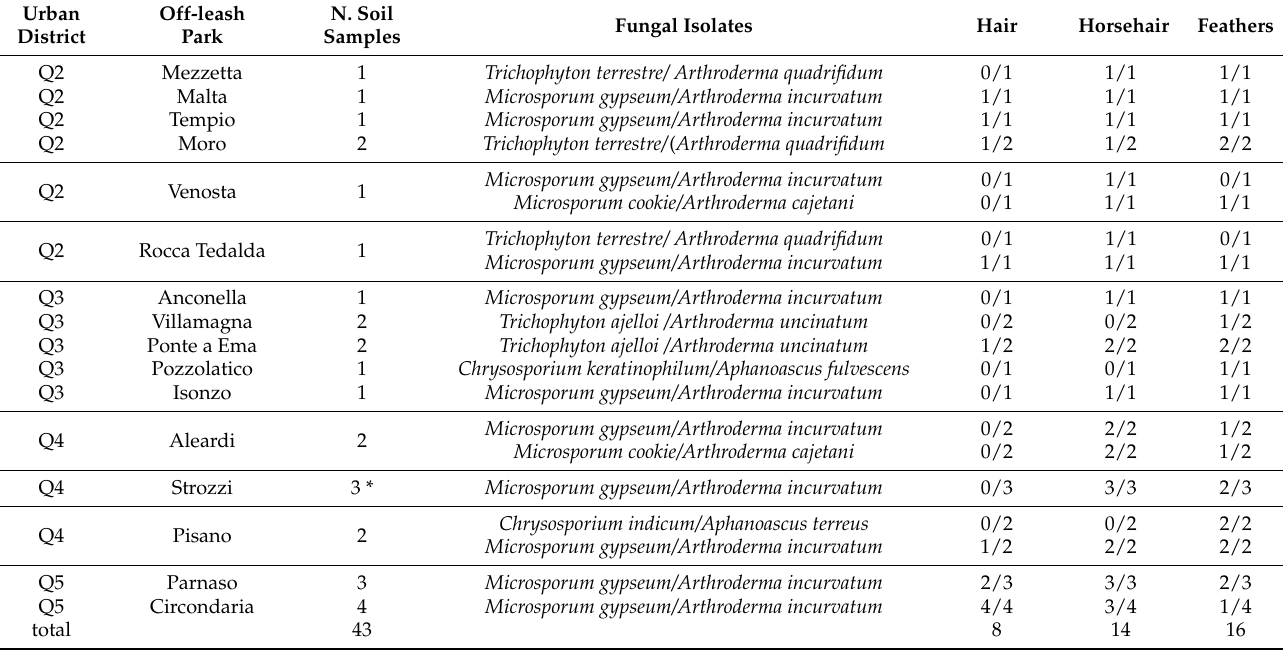
Table 3. The results of mycological analysis performed by hair bait technique on soil samples from selected areas. Urban Off-leash District